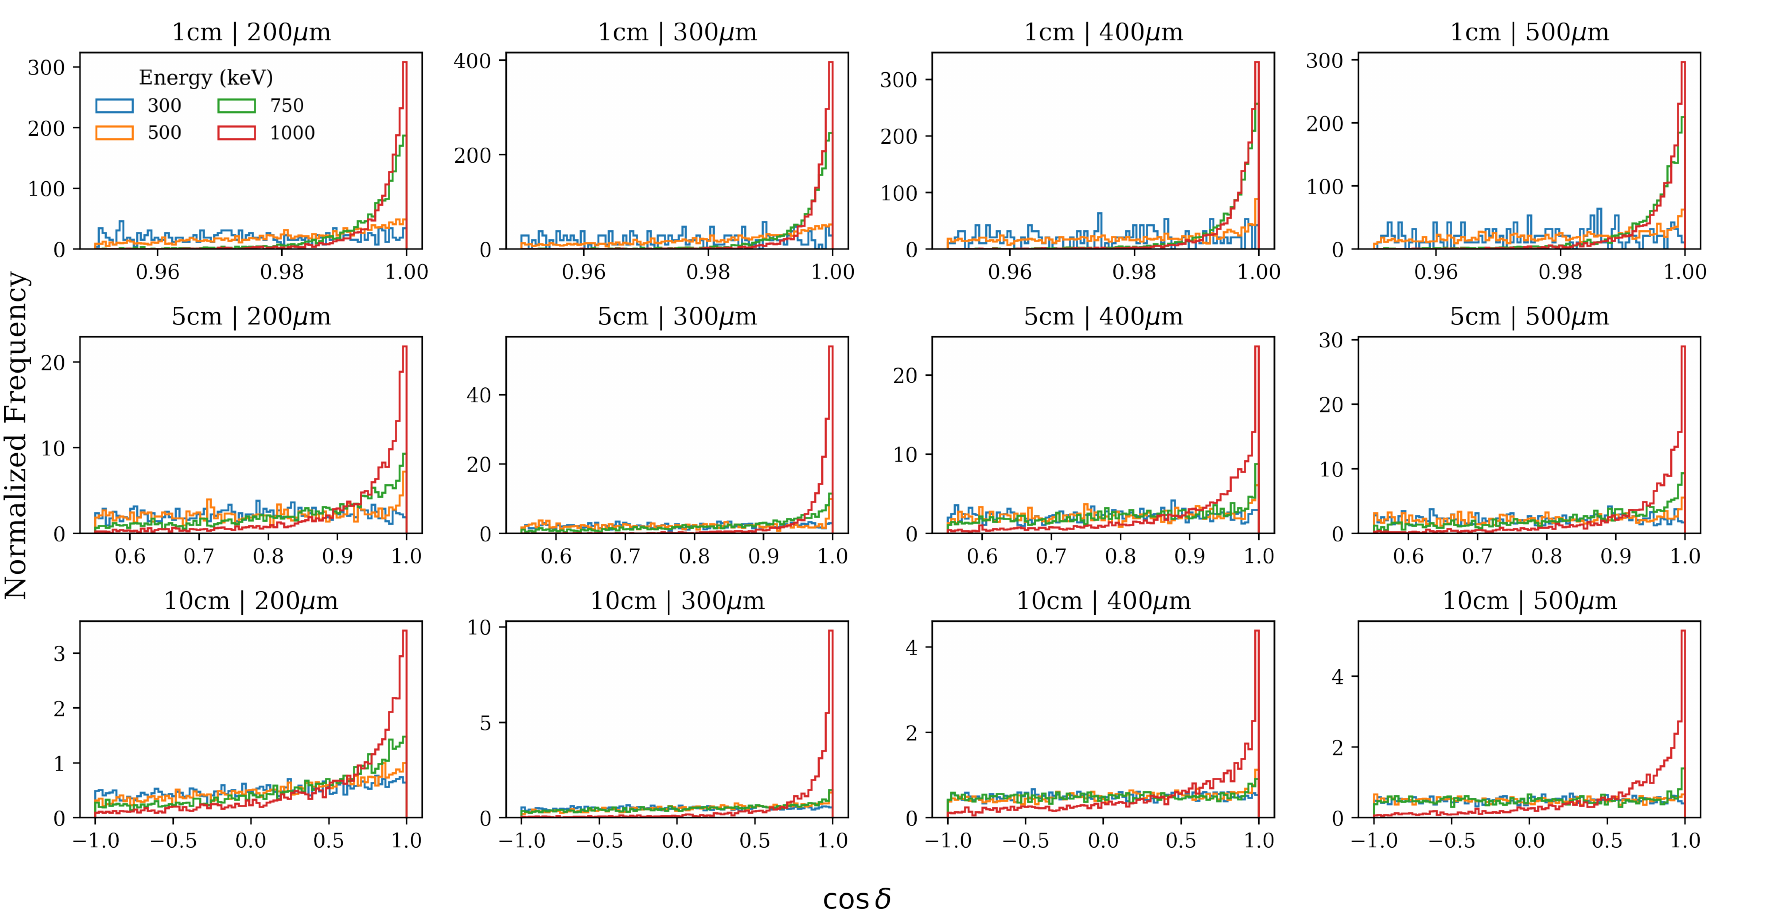
Figure 8. Prediction error for direction models trained over all energies and drift distances for a fixed pixel pitch where δ is the the angle between predicted and true initial electron direction. Combining all energies at a fixed drift length, the median δ is approximately the same across all pixel pitches and is around 10, 50 and 70 degrees for the 1, 5, and 10 cm drift